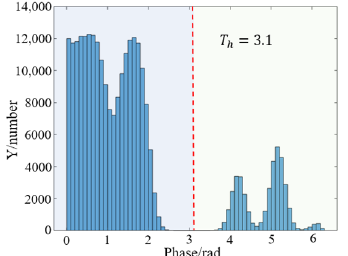
Figure 6. Histogram graph of | ϕ 12 d − ϕ 23 d | with noise.